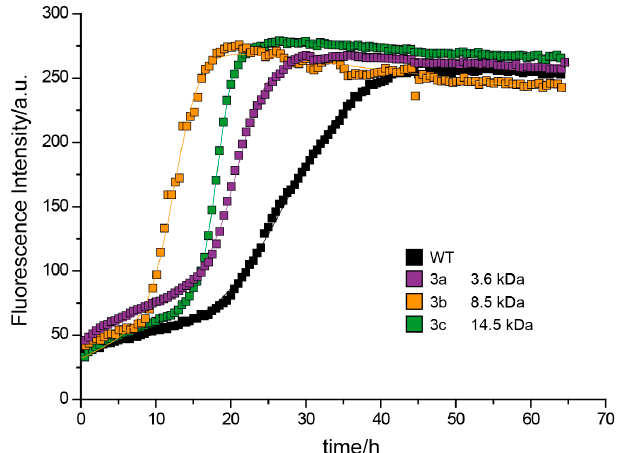
Figure 5. Time-dependent evolution of the ThT fluorescence intensity at λ = 482 nm of the polymer/A β 40 mixtures. For polymers 3b and 3c , the lag phase is shortened, while for polymer 3a , the lag phase is increased by one hour from t = 18.3 h (for pure A β 40 ) to t = 19.3 h.